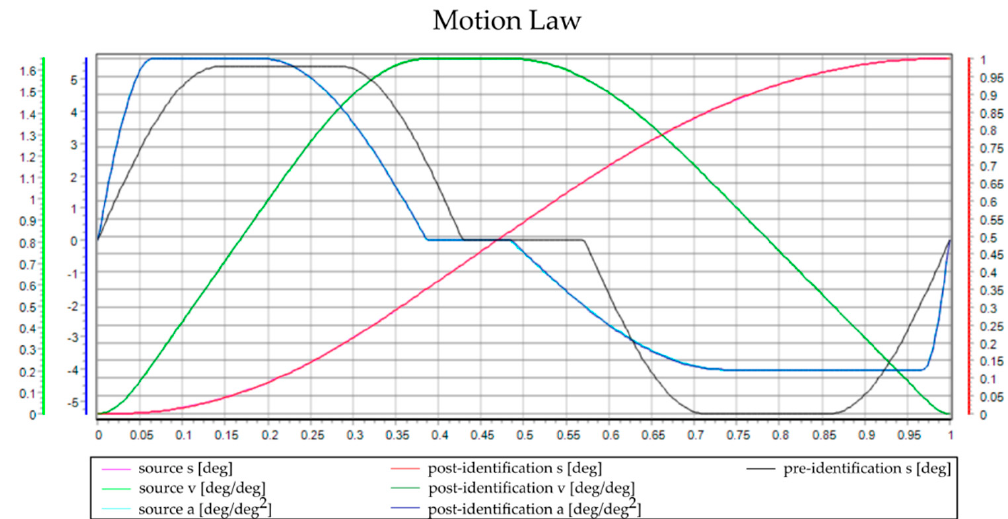
Figure 9. Simulated case, without simulated disturbances. (Black: acceleration of the starting step of the identification process; red: displacement; green: velocity; blue: acceleration, after the identification).